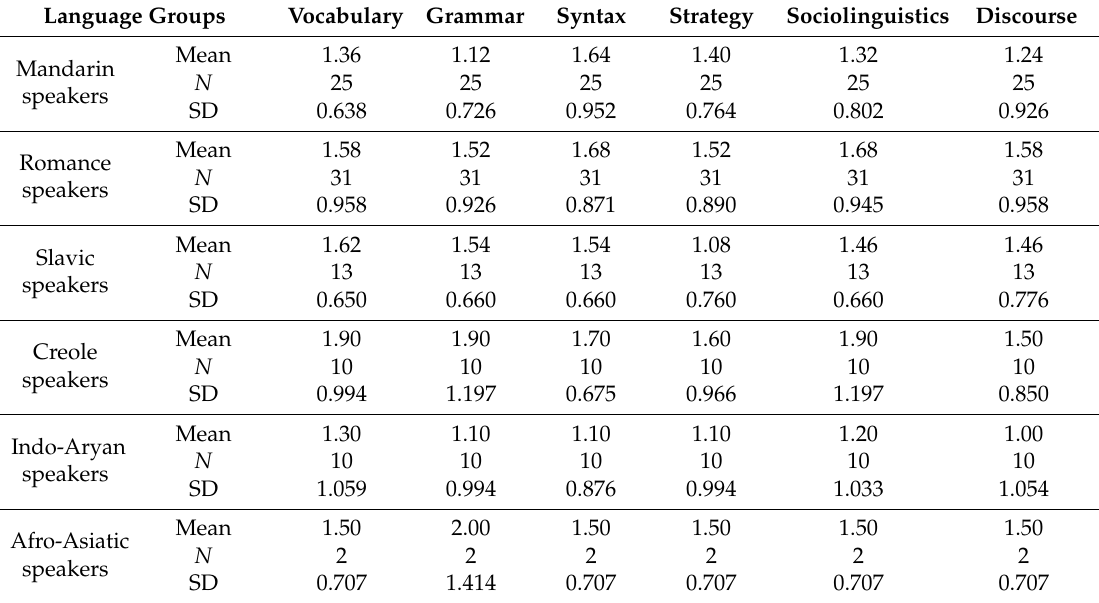
Table 4. Analysis of performance considering language groups.